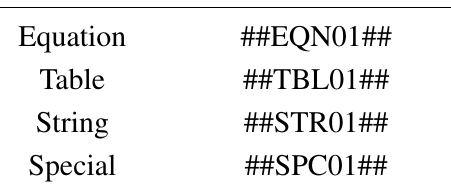
Table 1. Common Placeholders in HTML